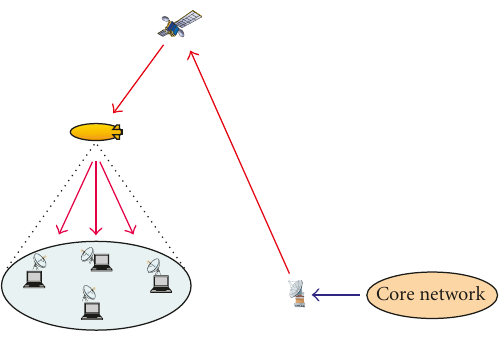
Figure 4: Integrated GEO